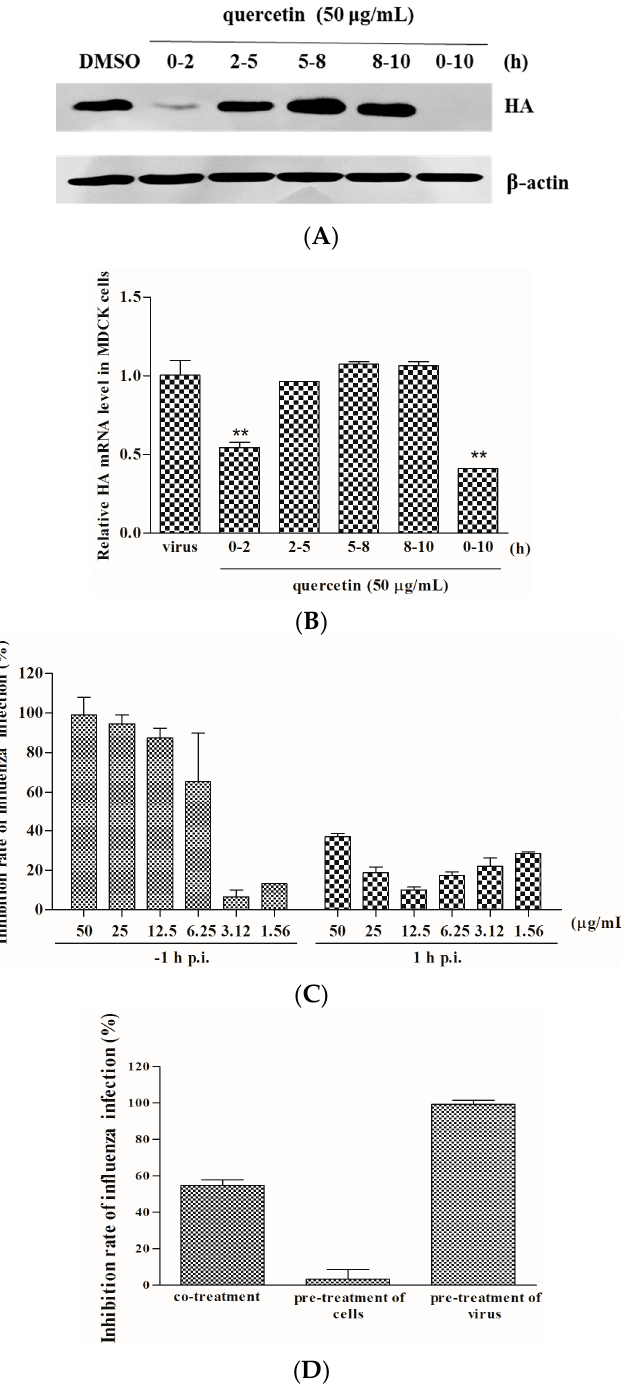
Figure 3. Quercetin performed the inhibitory activity in the initial stage of influenza virus infection. ( A ) The cells were infected with influenza A/Puerto Rico/8/34, and the virus-infected cells were then treated with quercetin in 0–2 h, 2–5 h, 5–8 h, 8–10 h and 0–10 h time intervals respectively. At 10 h post-infection, the viral HA protein was detected by Western blotting; ( B ) The cells were infected with influenza A/Puerto Rico/8/34, and the cells were then treated with quercetin in 0–2 h, 2–5 h, 5–8 h, 8–10 h and 0–10 h time intervals respectively. The viral HA mRNA was detected by quantitative real-time PCR at 10 h post-infection; ( C ) Serially diluted compound was added 1 h before virus infection ( − 1 h p.i.) or 1 h after virus infection (1 h p.i.). The extent of virus infection in the cell was determined at 48 h post-infection using MTT assay; ( D ) Different modes of treatment, namely co-treatment, pre-treatment of cells and pre-treatment of virus, were conducted to clarify whether the quercetin targets the host cell or the influenza virus. The protection of quercetin to the virus-infected cell was detected at 48 h post-infection by MTT assay.